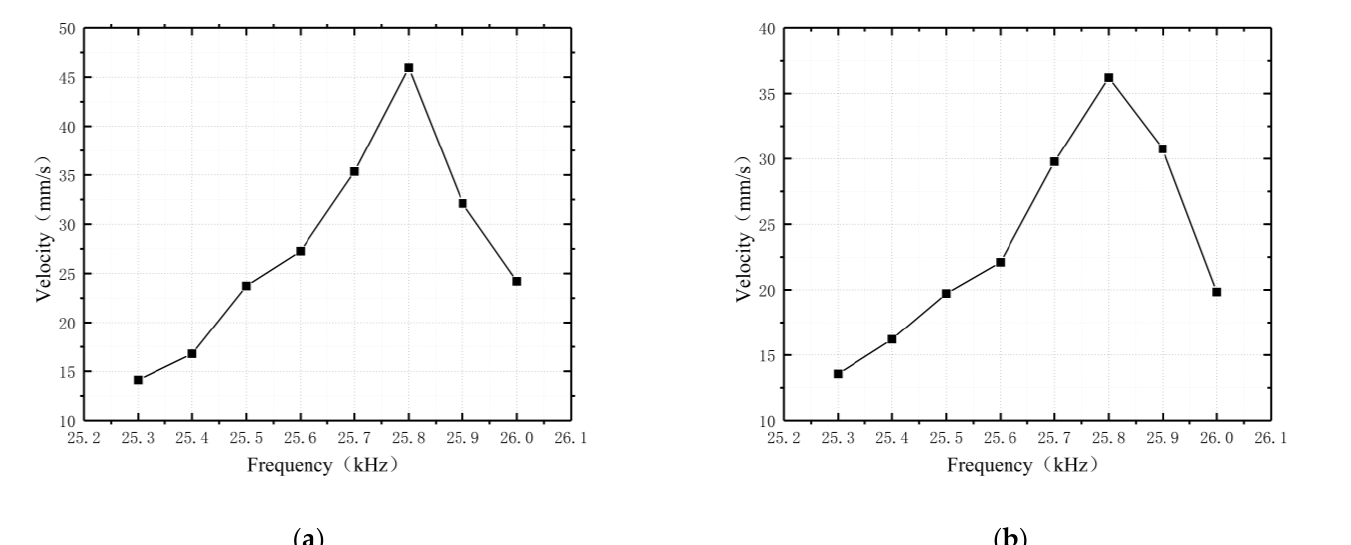
Figure 13. Velocity versus frequency characteristics: ( a ) upper surface driving foot; ( b ) lower surface driving foot.